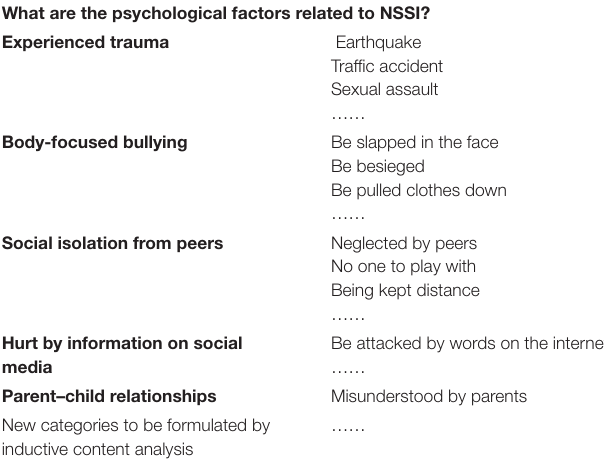
TABLE 2 | The unconstrained categorization matrix of psychosocial factors of NSSI. What are the psychological factors related to